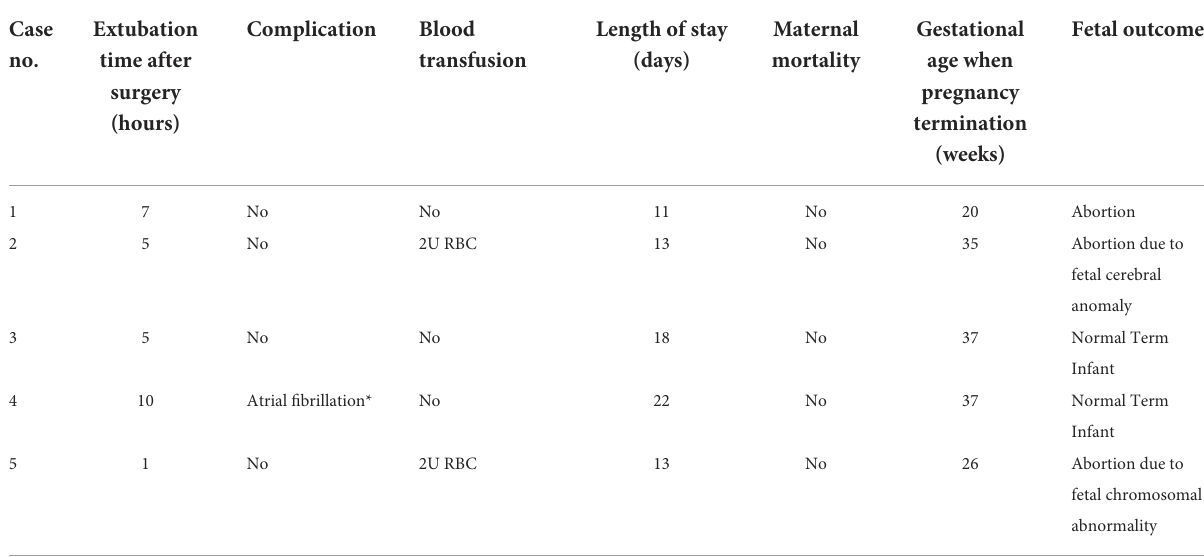
TABLE 3 Postoperative information of five patients undergoing MICS during pregnancy.